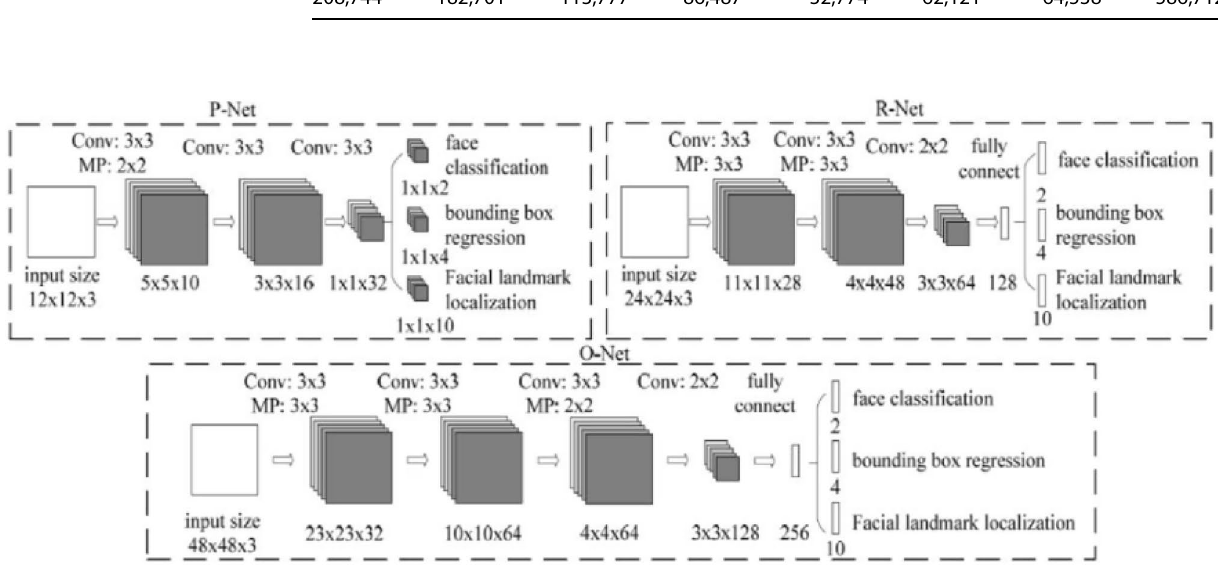
Table 2 Datasets by category for the total 586,712